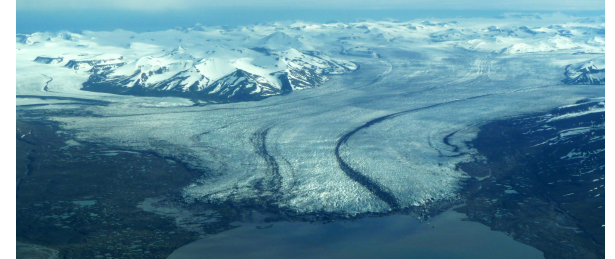
Fig. 10. Nathorstbreen glacier system during surge by 1 August 2012. Photo: SAS/M. Sund.